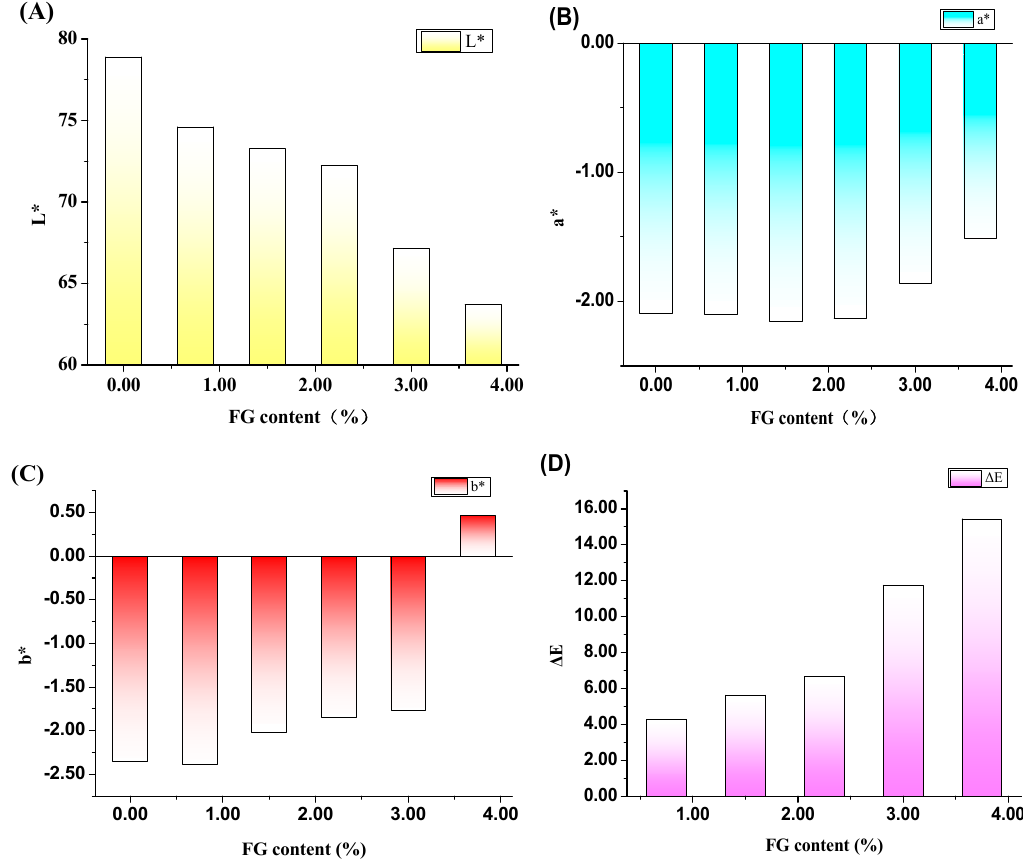
Figure 2. E ff ects of FG contents on the color of PVA / FG composite hydrogels ( A ) L *, ( B ) a *, ( C ) b *, and Figure 2. Effects of FG contents on the color of PVA/FG composite hydrogels ( A ) L*, ( B ) a*, ( C ) b*, and ( D ) ∆ E, (10% ( D ) Δ E, (10% PVA).